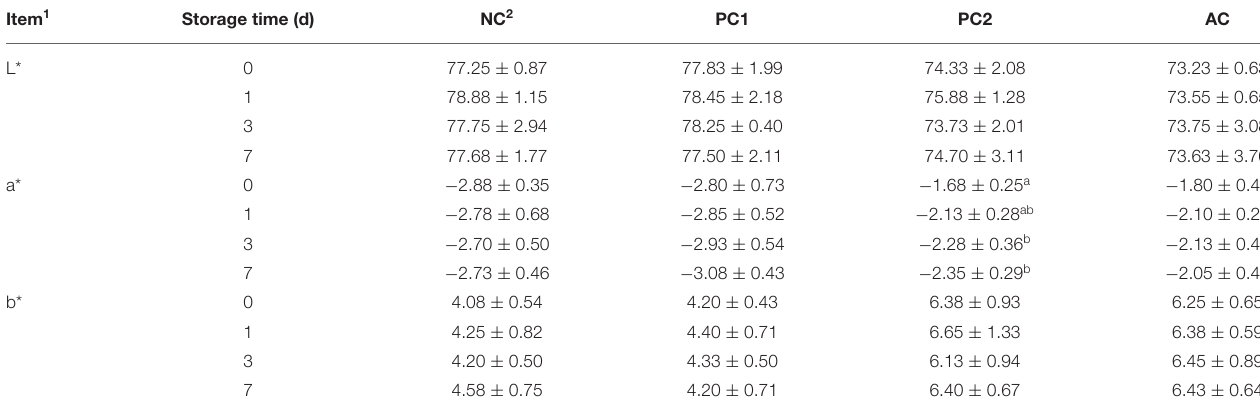
TABLE 6 | Effect of PCP on color parameters in milk during storage period. Item